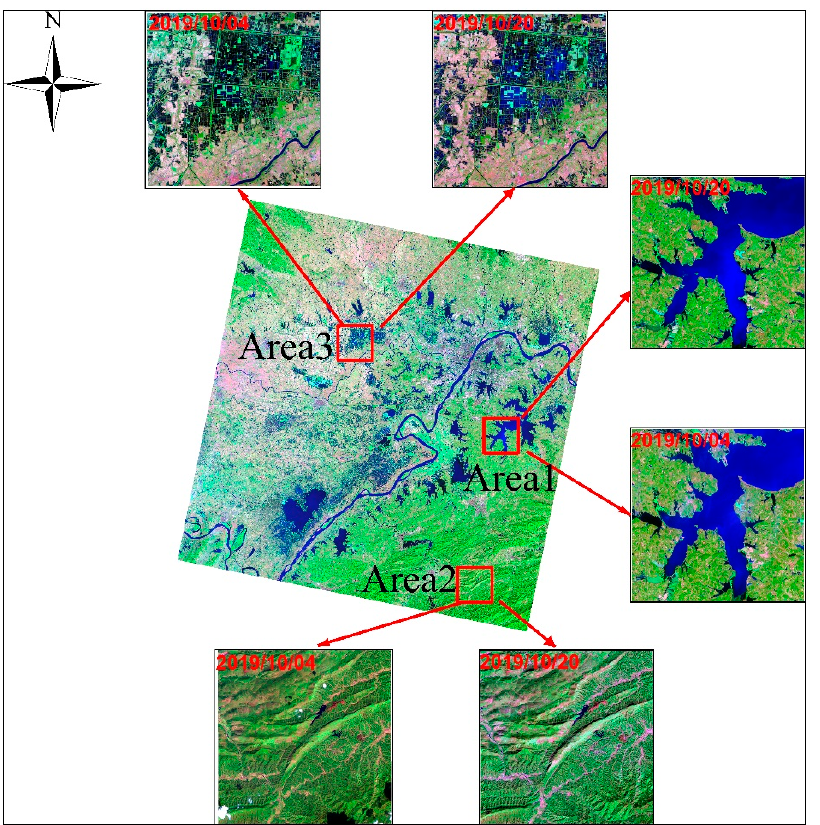
Figure 1. Landsat-8 remote sensing images are displayed in false color in bands 7, 5, and 3. Three local areas are extracted from this image. Area1 has a large area of water distribution with a simple ground environment and is only affected by vegetation; Area2 is affected by mountain shadow and vegetation; Area3 is located in the urban built-up area with scattered water distribution and is affected by roads and buildings. Table 1. Spectral band spatial resolution and wavelength of the Landsat-8 image. Landsat-8 OLI and TIRS Bands